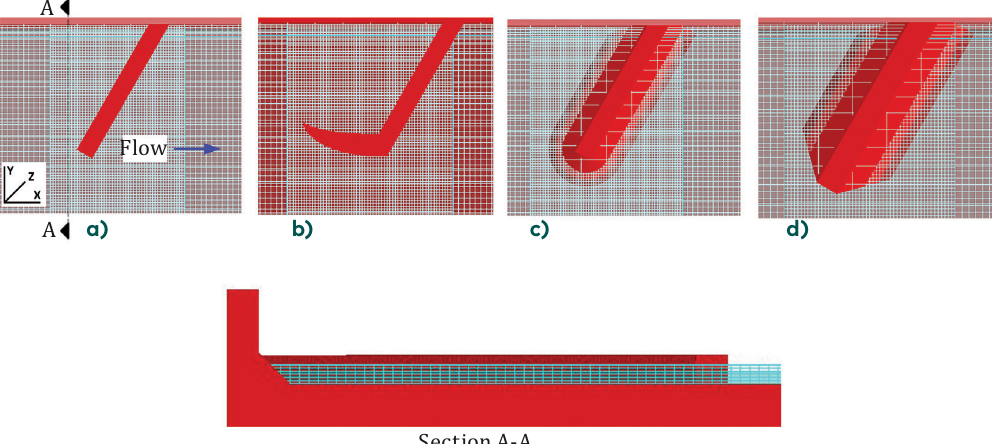
Figure 11. Cross-section and plan mesh grid for the flow-splitting Section embankment for a 30° skew: a) vertical-wall; b) elliptical guide bank; c) spill-through; d) wing-wall